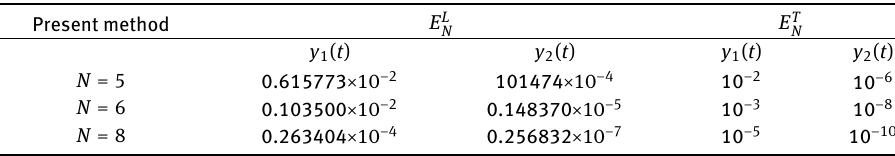
Table 3: Numerical result for Example 2.